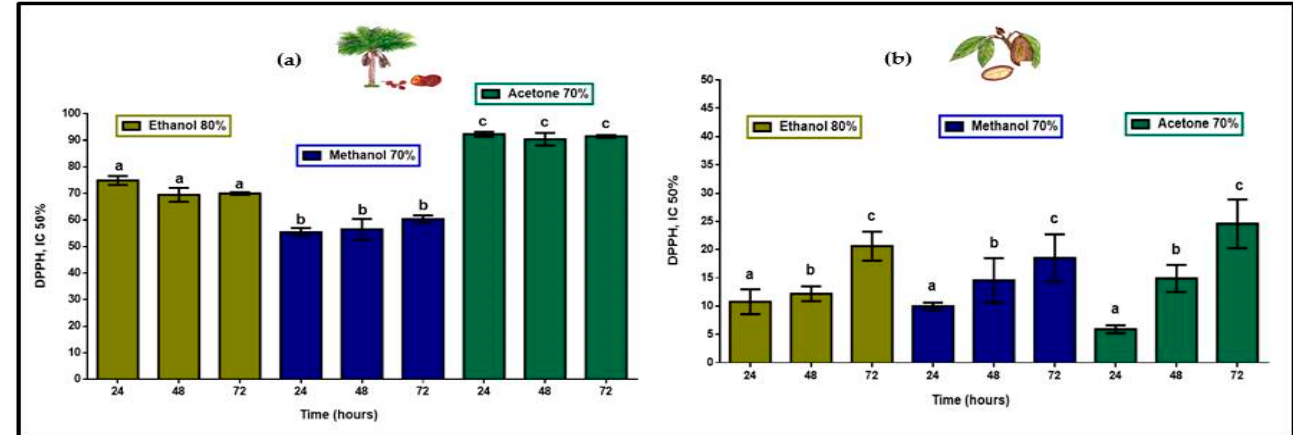
Figure 3. Antioxidant activity (mg AAE/100 g FP) in extracts of ( a ) M. flexuosa and ( b ) T. grandiflorum in ethanol, methanol, and acetone at 24, 48, and 72 h. Data are means ± standard deviation lower-case letters representing significant differences based on ANOVA followed by a Tukey test ( p < 0.05).